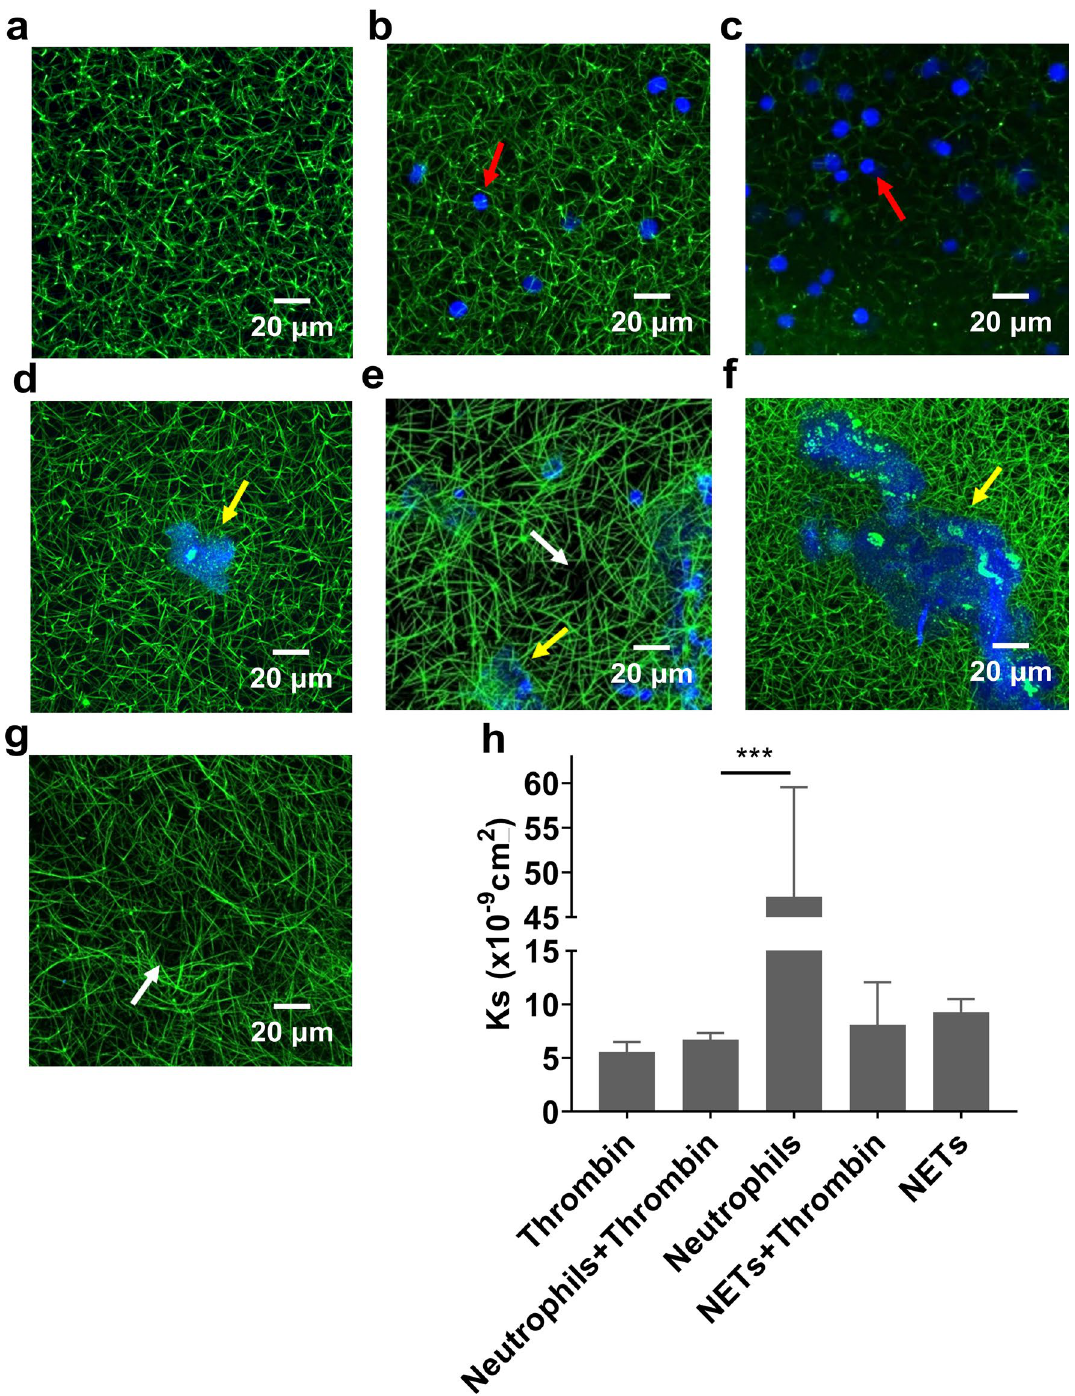
Figure 6. Clot density and the permeability of clots with human neutrophils or human NETs. ( a ) The overall structure of NPP clots triggered with only thrombin, ( b ) thrombin and neutrophils (200,000 cells/100 µl), ( c ) neutrophils only, ( d and e ) thrombin and NETs (generated from 200,000 cells/100 µl) and ( f and g ) NETs only were visualized by an confocal microscopy with a 40× oil immersion objective lens (1.4 NA). f and g are images of two positions from the same slide. Blue: DAPI-stained DNA. Green: Alexa Fluor 488 labeled fibrinogen. Red arrows indicate neutrophils, yellow arrows indicate NETs and white arrows indicate large pores. ( h ) The permeation coefficient (Darcy constant [Ks]) of clots were quantified. Other concentrations: plasma was diluted 1:6 for confocal (except in figure e was 1:3) and 1:3 for permeation, CaCl 2 (3.33 mM), thrombin (0.1U/ml). Error bars represent SEM of three technical replicates in triplicates. *** P <